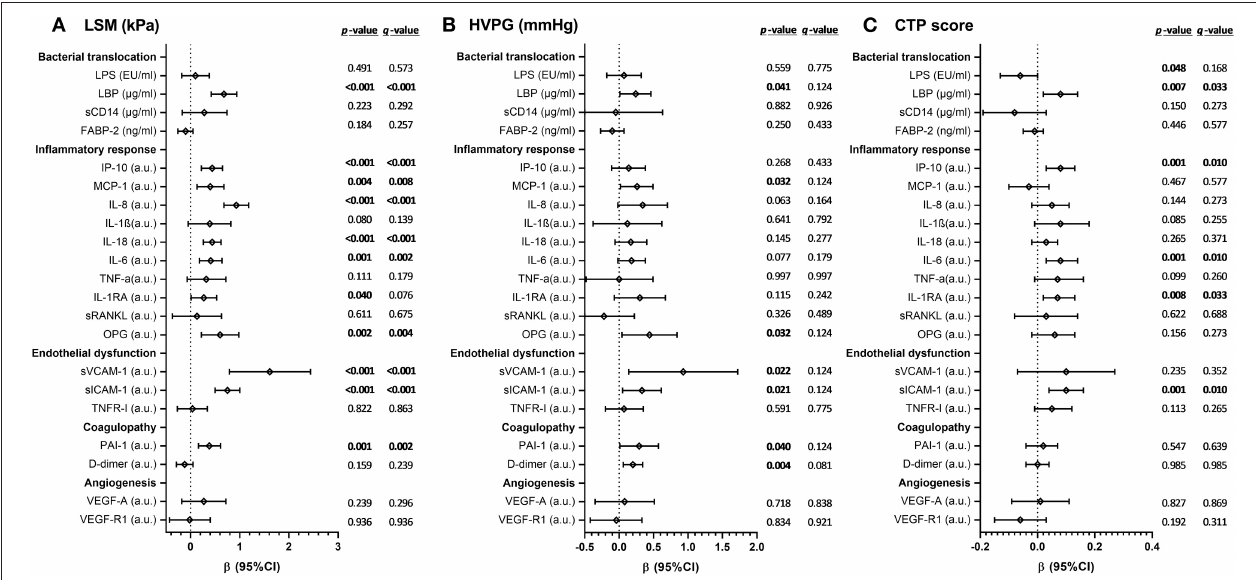
FIGURE 1 | Association between the change in values of plasma biomarkers and severity scores of liver disease [ A , LSM (kPa); B , HVPG (mmHg); C , CTP score] during HCV treatment in HIV/HCV-coinfected patients with advanced cirrhosis. Statistics: Data were calculated by GLM mixed models. Values are expressed as regression coefficient ( β ) and 95% of confidence interval (95%CI). p-Values , raw p -values; q -values, p -values corrected for multiple testing using the false discovery rate ( FDR ) with Benjamini and Hochberg procedure. The statistically significant differences are shown in bold. HCV, hepatitis C virus; HIV, human immunodeficiency virus; LSM, liver stiffness measurement; CTP, Child-Pugh-Turcotte; HVPG, hepatic venous pressure gradient; mmHg, millimeter of mercury; kPa, kilopascals; a.u., arbitrary units of fluorescence; sCD14, soluble CD14; LPS, lipopolysaccharide; FABP2, fatty acid-binding protein 2; LBP, lipopolysaccharide binding protein; IL, interleukin; IL-1RA, interleukin-1 receptor antagonist; TNF- α , tumor necrosis factor alpha; IP-10, IFN- γ -inducible protein 10; MCP1, monocyte chemoattractant protein-1; OPG, osteoprotegerin; sRANKL, soluble receptor activator of nuclear factor-kappa B ligand; sVCAM-1, soluble vascular cell adhesion molecule 1; sICAM-1, soluble intercellular cell adhesion molecule 1; sTNFR-1, soluble tumor necrosis factor receptor 1; PAI-1, plasminogen activator inhibitor-1; VEGF-A; vascular endothelial growth factor A; sVEGF-R1, soluble receptor1 for vascular endothelial growth